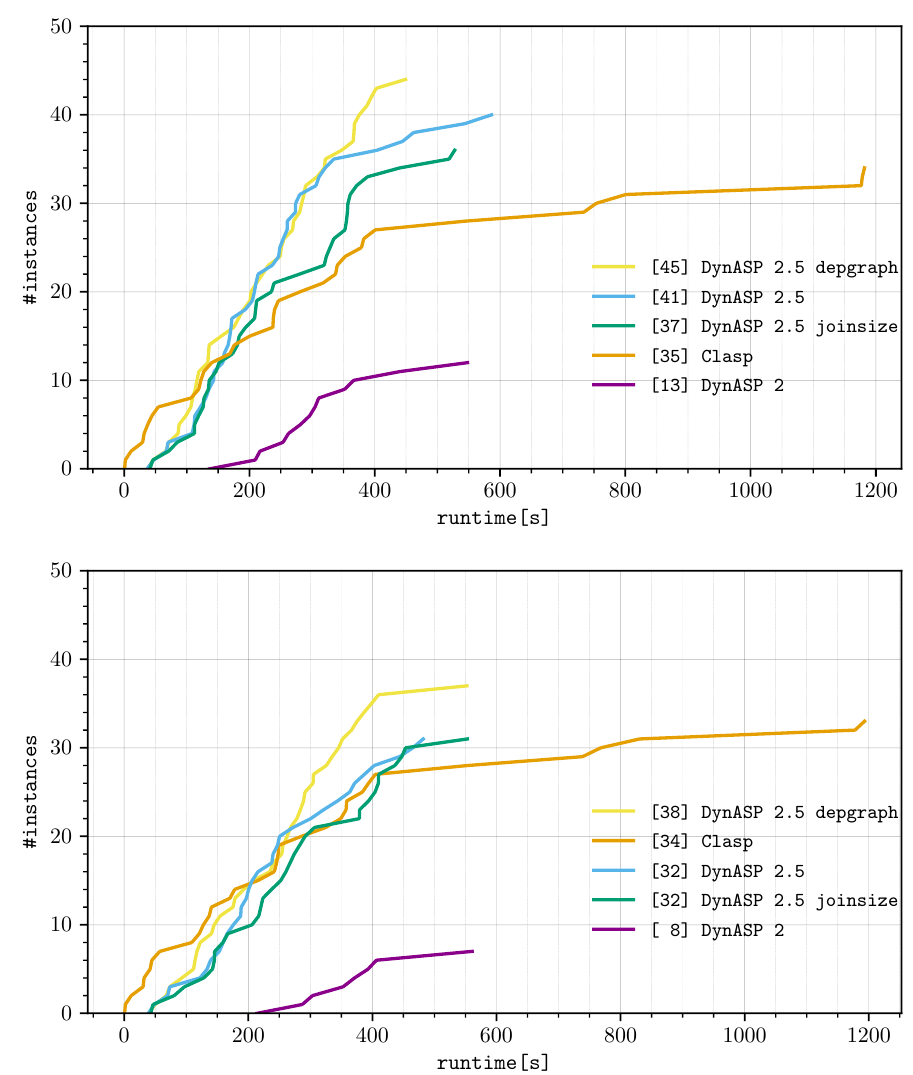
Figure 6. Runtime results illustrated as cumulated solved instances. The y-axis labels consecutive integers that identify instances. The x-axis depicts the runtime. The instances are ordered by running time, individually for each solver. The first plot ( top ) shows the best results among five TDs and the lower plot ( bottom ) depicts the median runtime among five